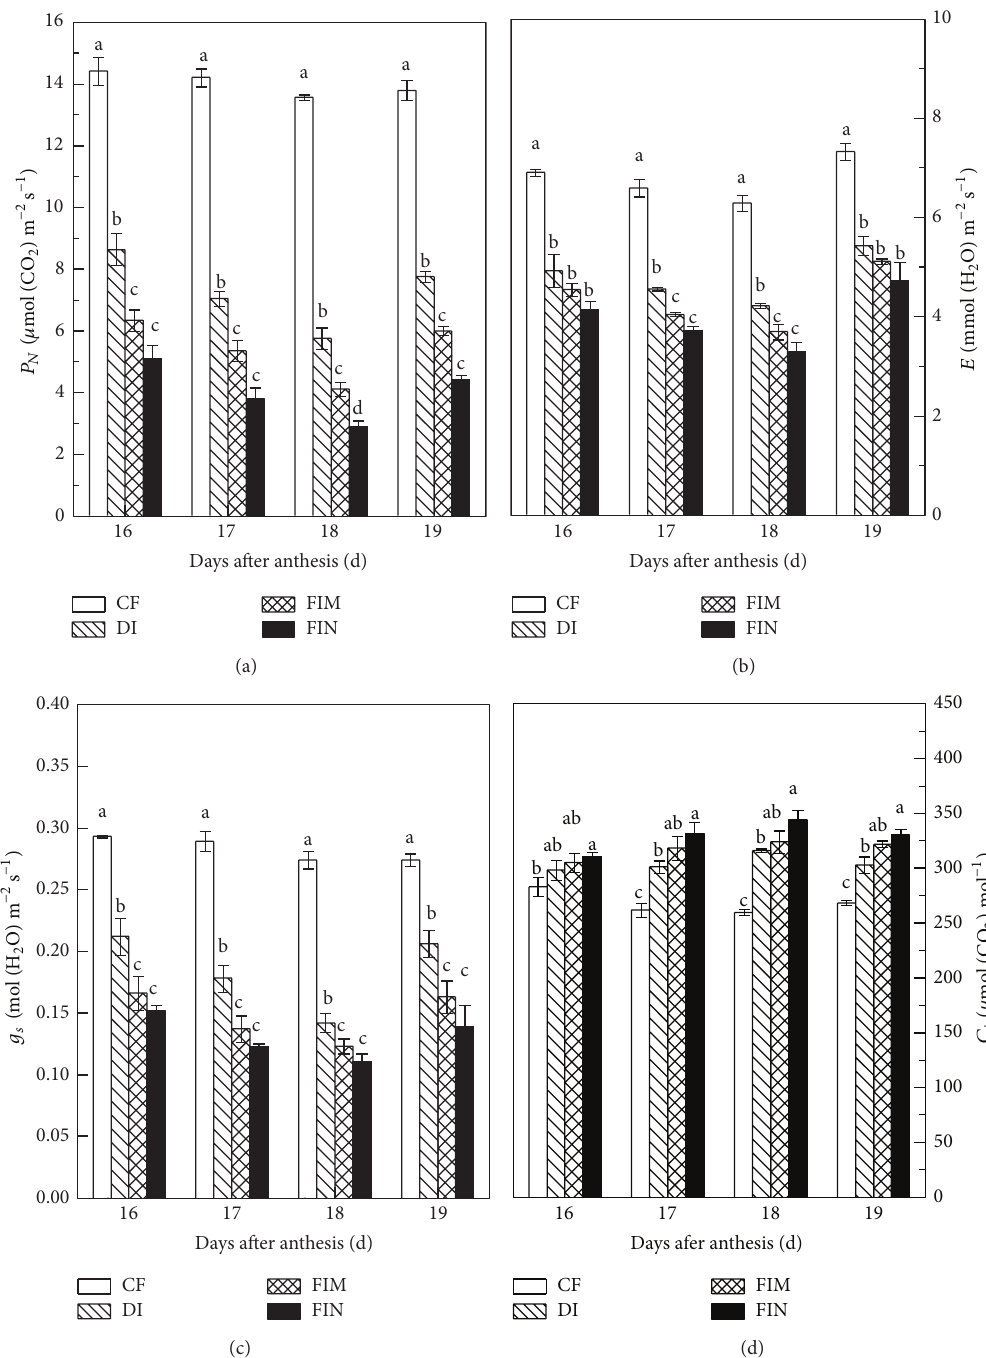
Figure 5: The 𝑃 𝑁 (a), 𝐸 (b), 𝑔 𝑠 (c), and 𝐶 𝑖 (d) of cultivar Ninggeng28 ( Oryza sativa L.)under different treatments from the 16th day after anthesis to the 19th day after anthesis in Shihezi. The CF indicates conventional flooding, and the DI, FIM, and FIN are plastic film mulching with drip irrigation, plastic film mulching with furrow irrigation, and no mulching with furrow irrigation, respectively. Vertical bars represent SEofthemean,theSEwascalculatedacrossfivereplicatesforeachyearandaveragedforthe2years.Valuesofeachmeasurementdatefollowed by the same letter indicate no significant differences ( 𝑃 < 0.05 ) according to least-significant-difference